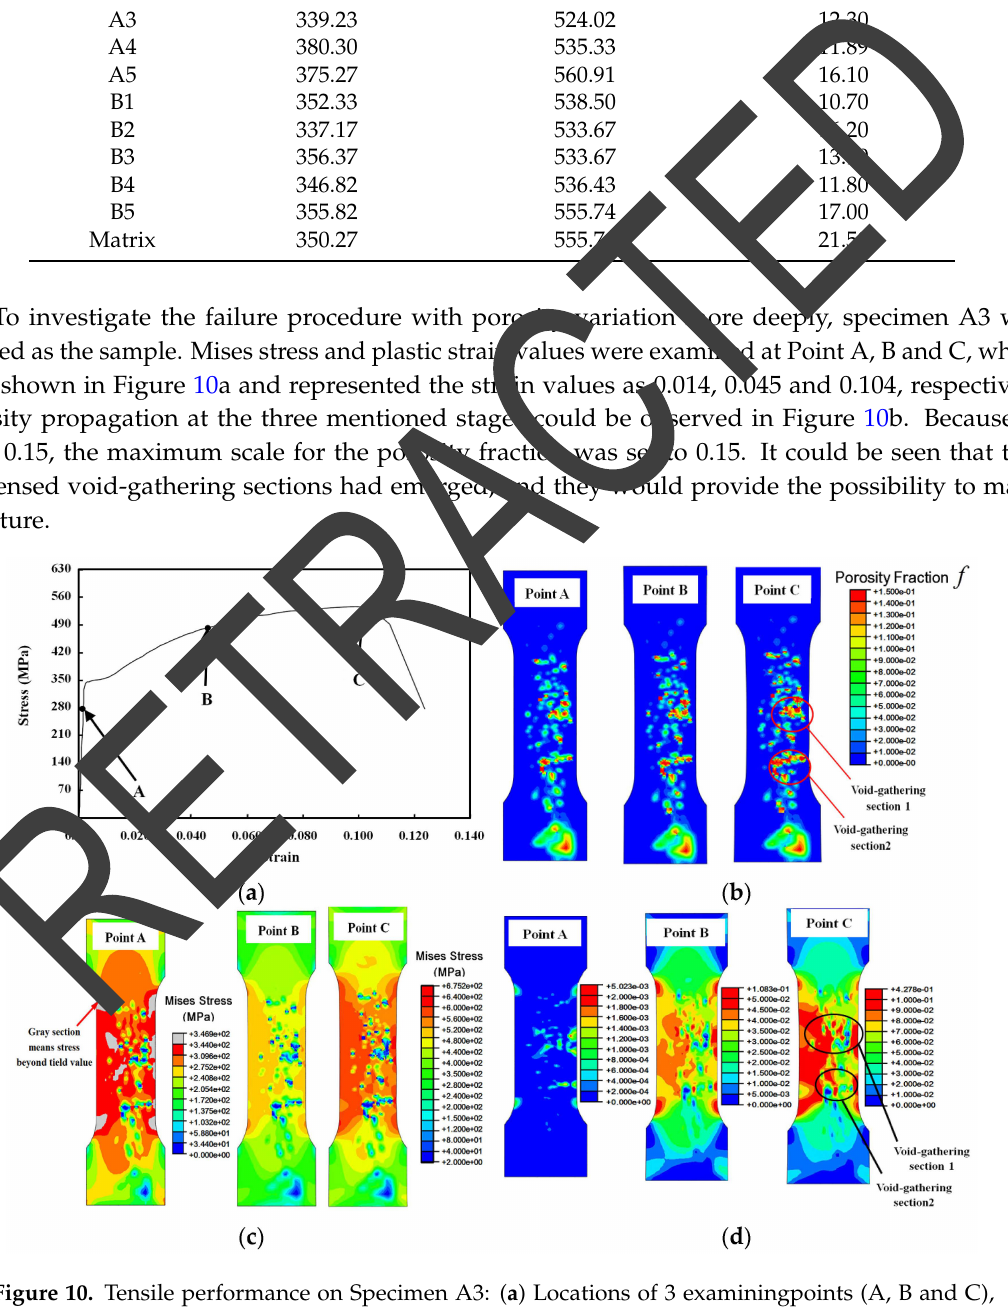
Figure 10. Tensile performance on Specimen A3: ( a ) Locations of 3 examiningpoints (A, B and C), which represent different stages of strain; ( b ) Porosity propagation contours at three examining points (A, B and C); ( c ) Stress propagation contours; ( d ) Plastic strain propagation contours at three examining points (A, B and